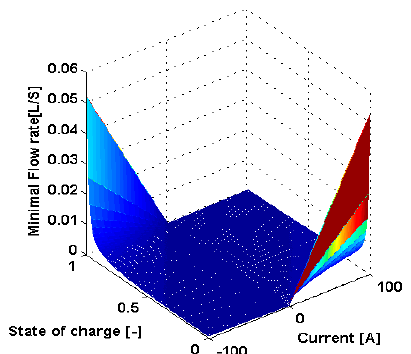
Figure 12. The change of theoretical minimum flow rate with current (I) and charge state (SOC). (“-” denotes charging.)